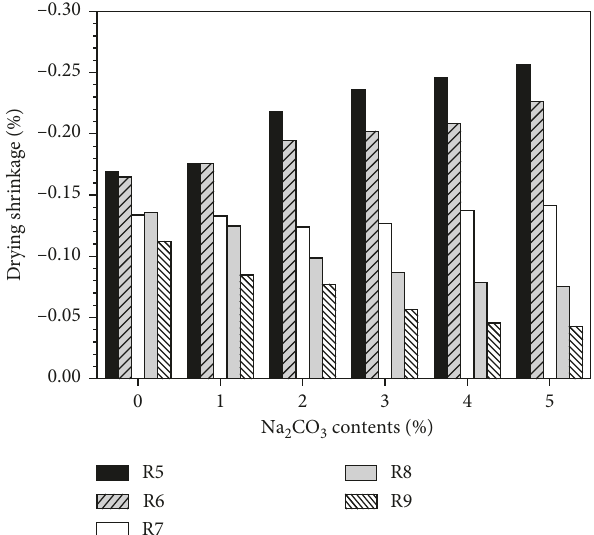
Figure 7: Drying shrinkage for HVSC pastes containing Na